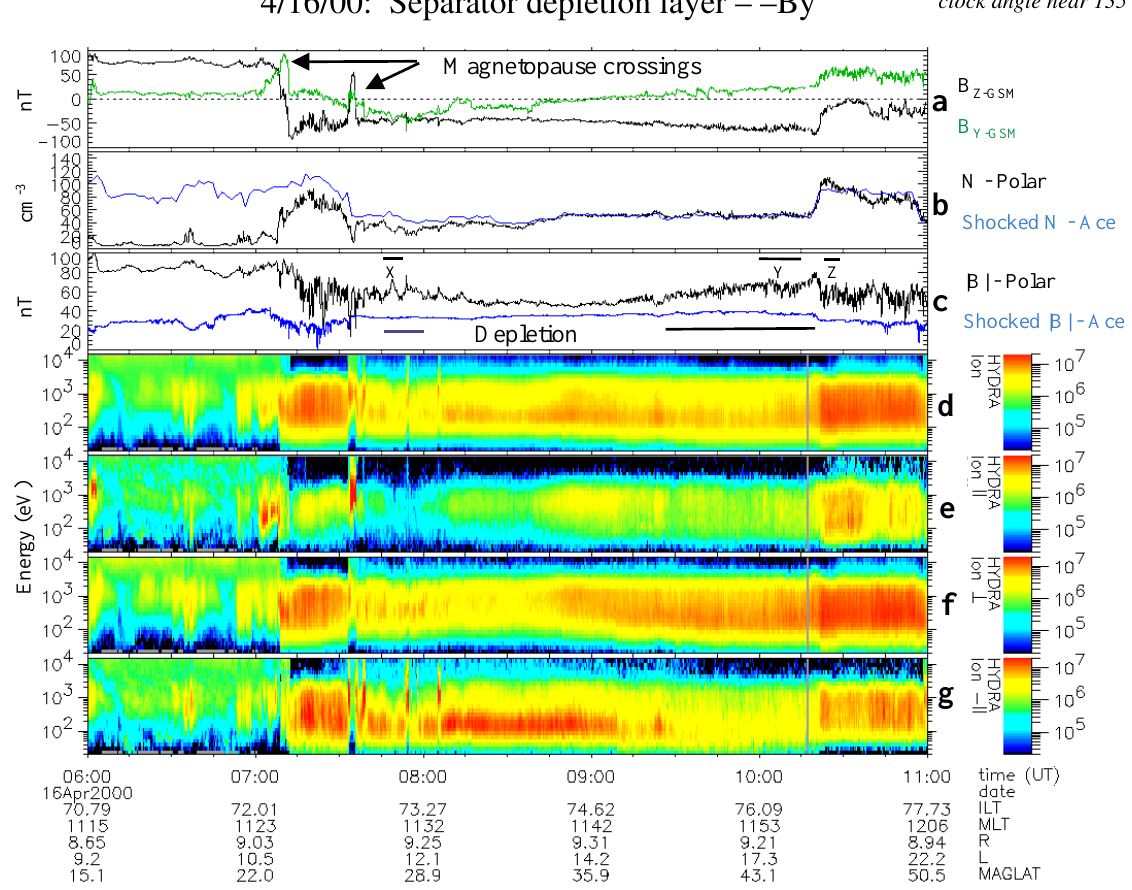
Fig. 5. An example from Polar located prenoon at 30 ◦ MLAT and 11:32 MLT in the same format as Fig. 1. The signatures of depletion are seen briefly just before 08:00 UT when IMF B Y is negative and comparable to B Z . Subsequently, as the magnitude of B Y decreases, antiparallel ion fluxes and the total ion density return from merging somewhere below the spacecraft. Depletion is seen on the dusk side of noon for the opposite polarity of B Y near 10:00UT. Three intervals noted by X, Y, and Z indicate the data on which the regression analyses in Fig. 12 were